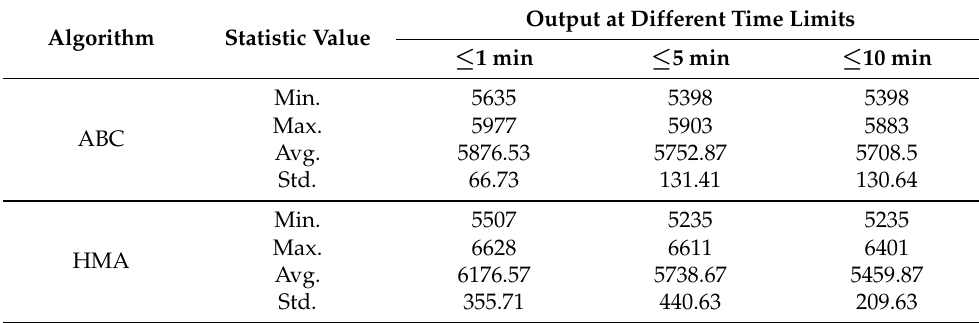
Table 4. Statistics of the total cost of the globally best solution of the HMA and the ABC algorithms on the “egl-s1-A” instance, within different time limits.